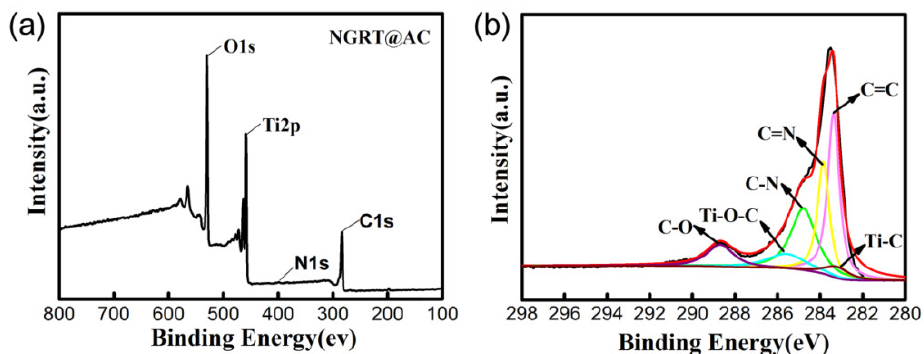
Figure 2. ( a ) The XPS full spectrum of the NGRT@AC nanocomposite and ( b ) the high-resolution C1s spectra of NGRT@AC.